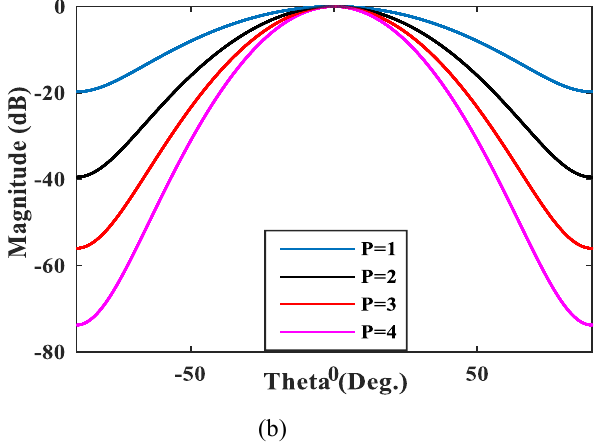
Figure 7. Array factors of triangular fractal planar array antennas generated by concentric (a) elliptical and (b) circular ring sub array generators for S=1 up to four iterations.